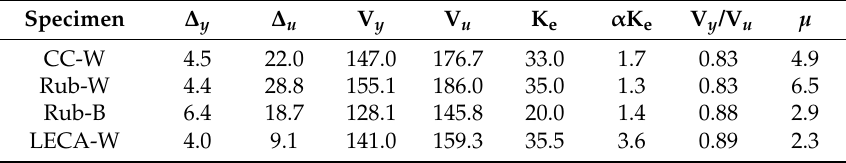
Table 3. Characteristics of the bi-linearized capacity curves of the test